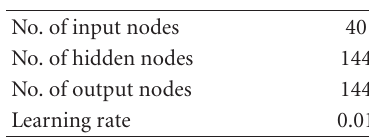
Table 2: Parameter of ANN.